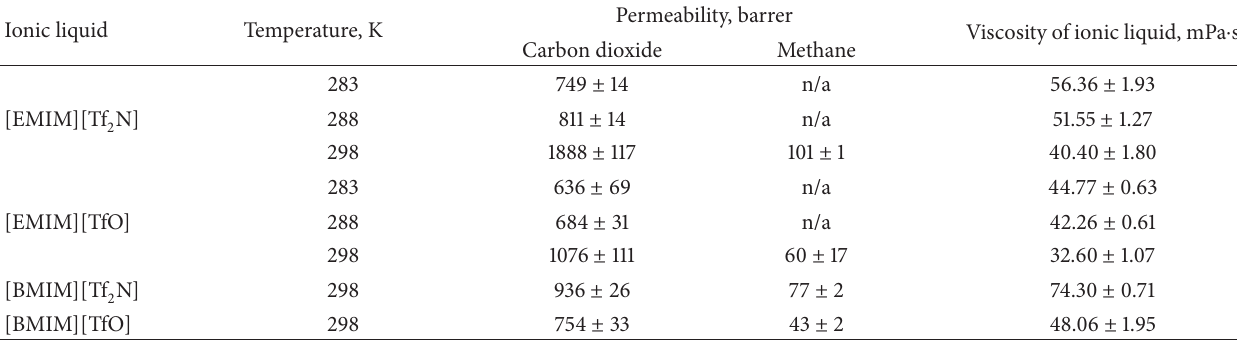
Table 6: Permeability of carbon dioxide and methane through SILMs (with PP support) at different temperatures. Ionic liquid